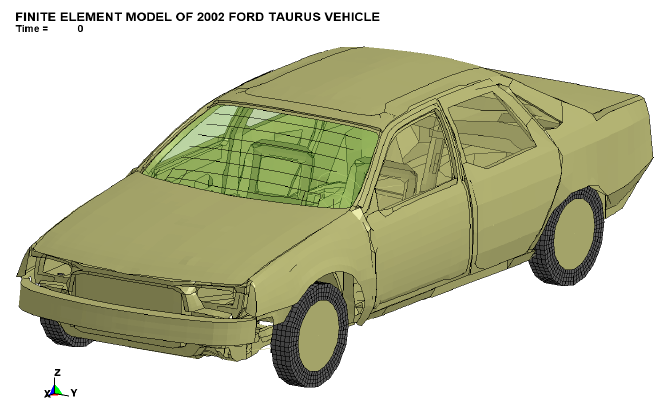
Figure 5. The 2002 Ford Taurus vehicle model used in LS-DYNA Impact Simulation.